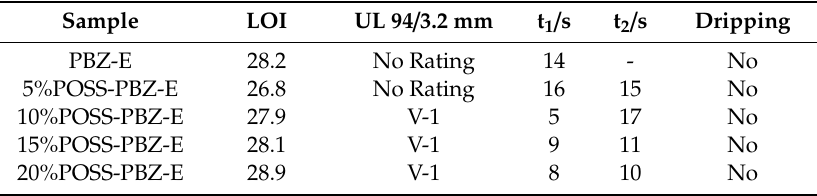
Table 4. The LOI and vertical combustion analysis of